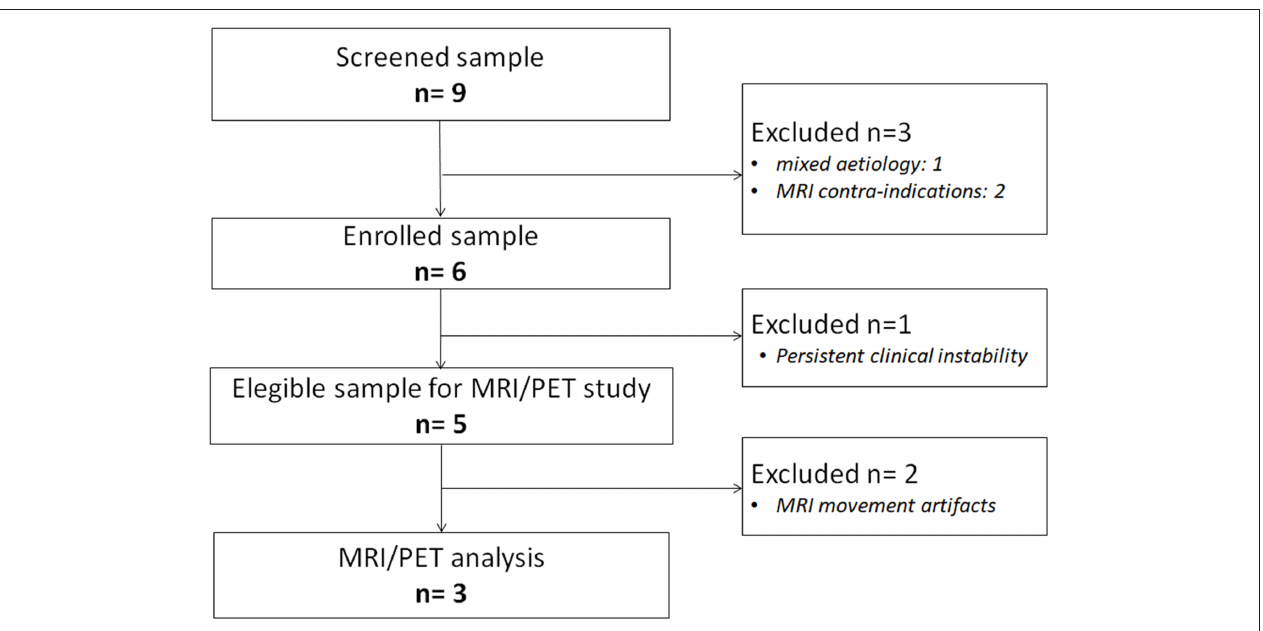
outside the network (ROF = − 1.71). VL and VO were recognized as not neuronal in both scans, while VM appeared well preserved with a better spatial pattern in T1 acquisition (ROF = 0.32